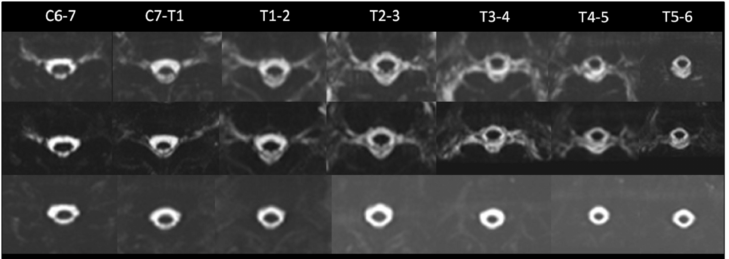
Figure 2. A 56-year-old male with SIH. ( Upper row ) Initially, MR myelography revealed CSF leakage at the bilateral C6-7, C7-T1, T1-2, T2-3, T3-4, and T4-5 neural sleeves. (no. of spinal CSF leakage = 12). ( Middle row ) Post-EBP MR myelography performed three days after EBP revealed CSF leakage at the bilateral C6-7, C7-T1, T1-2, T2-3, T3-4, and T4-5 and new CSF leakage along the bilateral T5-6 neural sleeves with persistent epidural fluid accumulation (no. of spinal CSF leakage = 14) A second epidural blood patch was performed. ( Lower row ) Three-month MR myelography revealed complete resolution of CSF leakage. (Leakage No = 0).